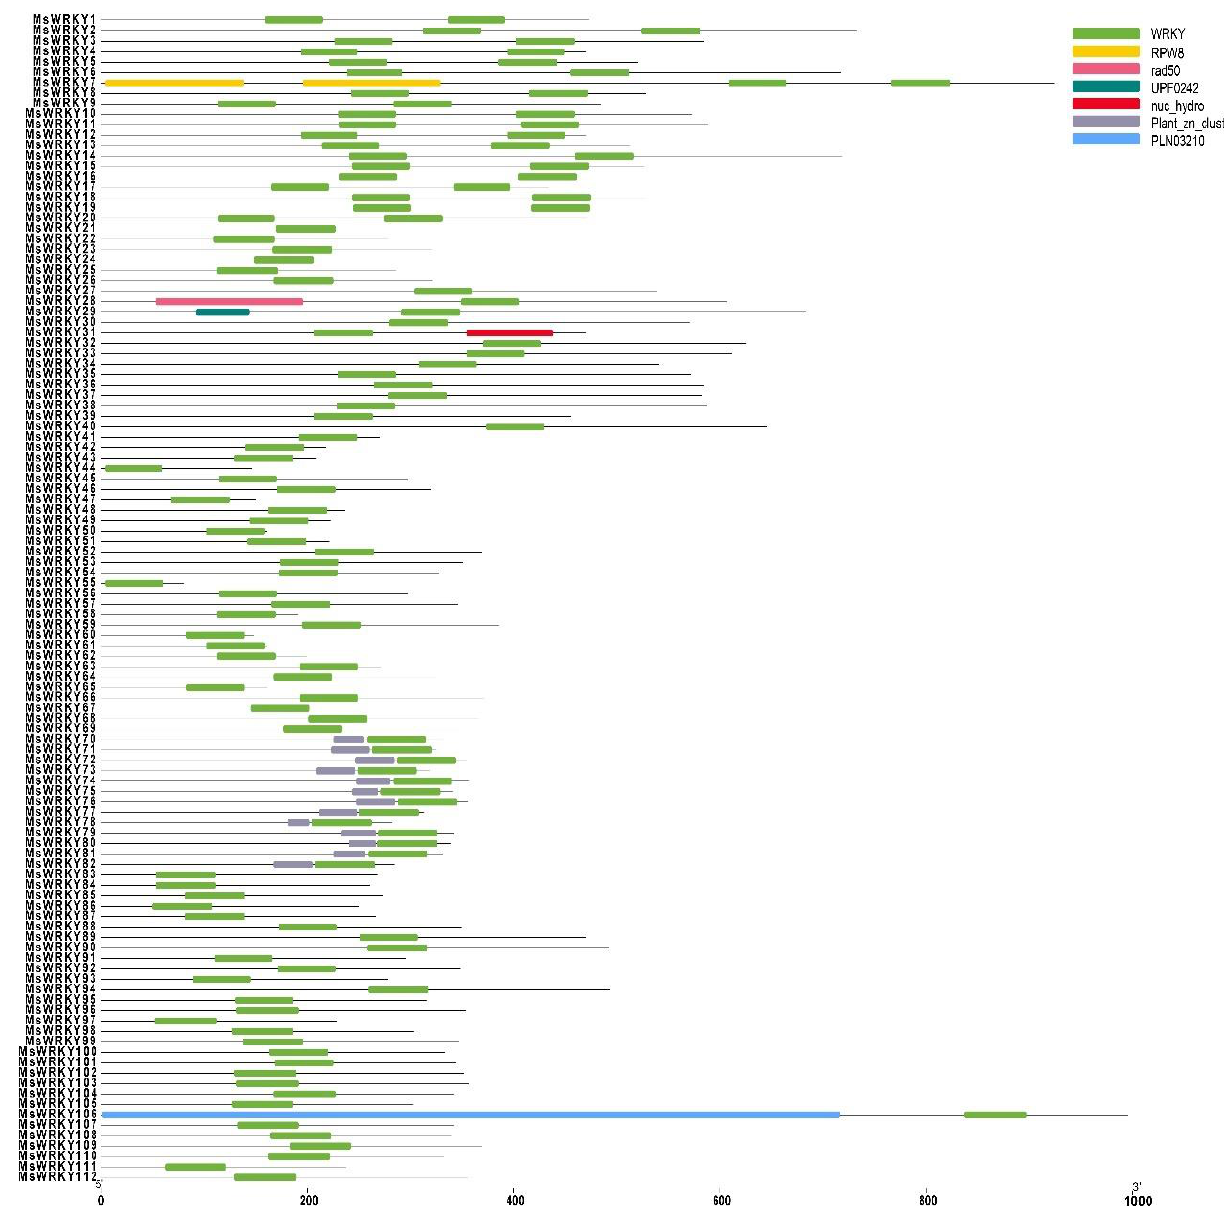
Figure 3. The specific transmembrane-binding domains of MsWRKY proteins. WRKY: WRYK domain; RPW8: RESISTANCE TO POWDERY MILDEW8.2 domain; rad50: rad50; UPF0242: UPF0242 domain; nuc_hydro: Nucleoside hydrolases; Plant_zn_clust: zinc-binding domain; PLN03210: PLN03210 domain.